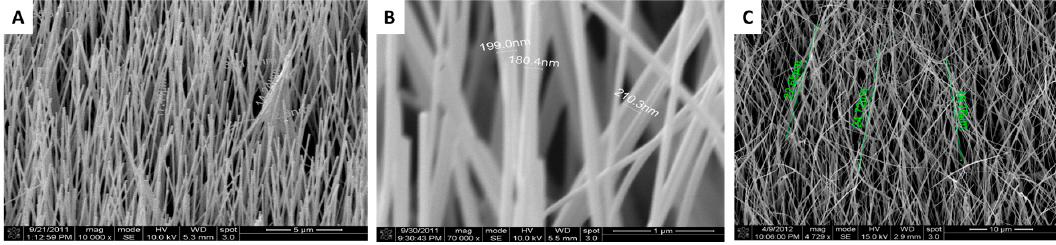
Figure 1. Scanning electron microscopy (SEM) images of the cross-section of nanochips. The two left panels ( A , B ) show vertically aligned nano-rods varying in length from 20 to 30 µm and width from ~100–200 nm. Rightmost panel ( C ) represents the nanochip with rods having a random alignment.